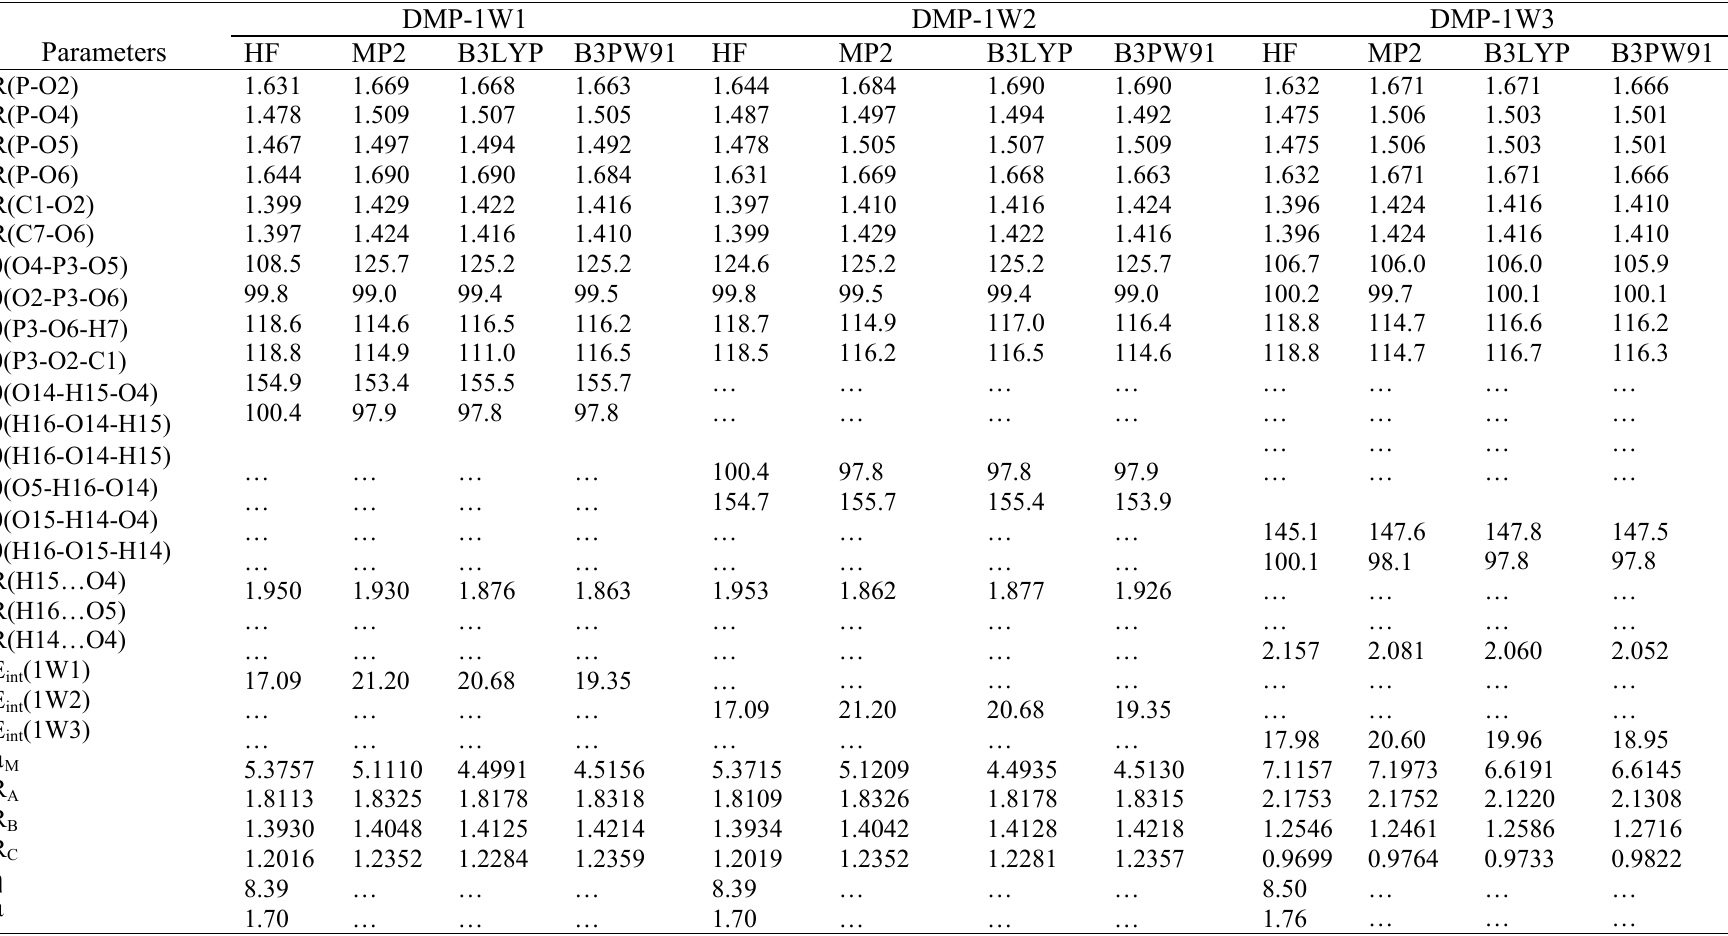
Table 2. Optimized geometrical parameters (bond length in Å, bond angle in degrees), rotational constants R Debye), chemical potential µ (in eV) and chemical hardness η (in eV) for DMP-1water